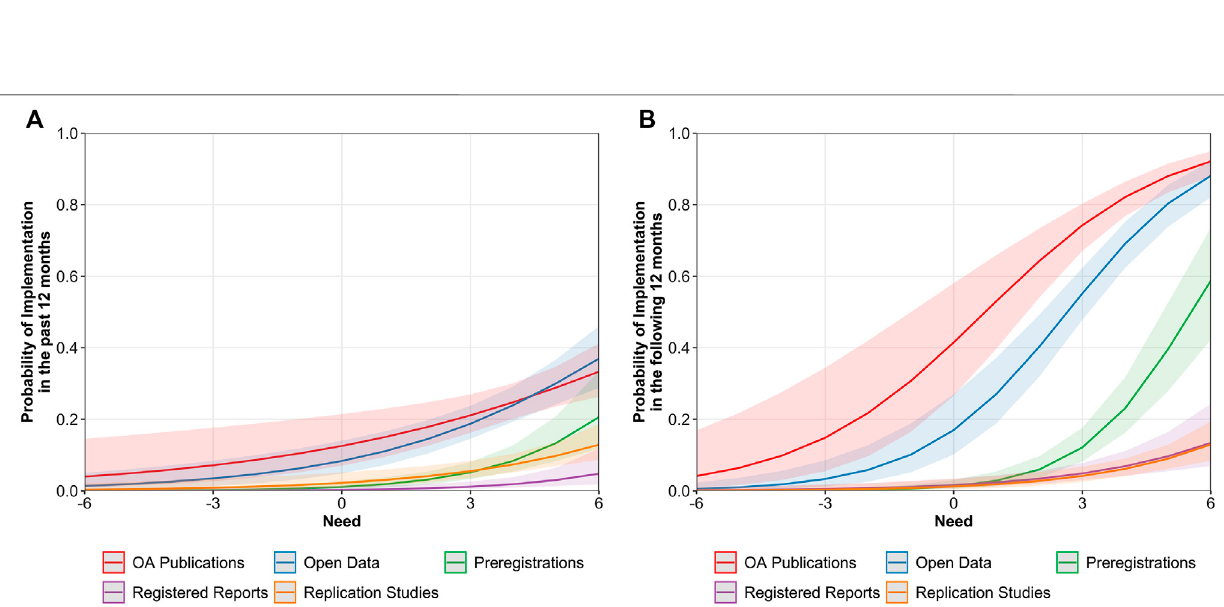
Frontiers in Research Metrics and Analytics |